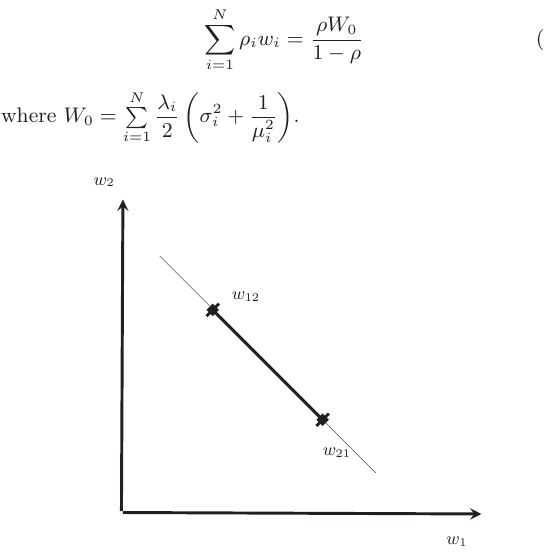
Figure 1: Achievable performance vectors in a two class M/G/1 queue